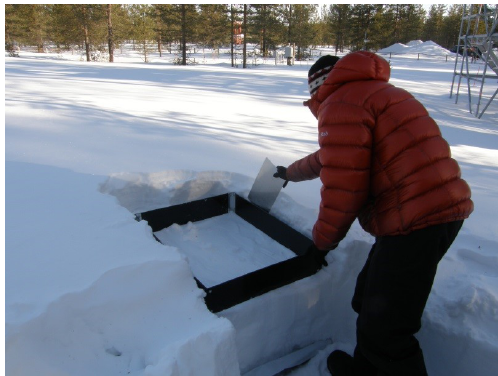
Figure 2. Setup for radiometer measurements with a 50 ◦ inclination